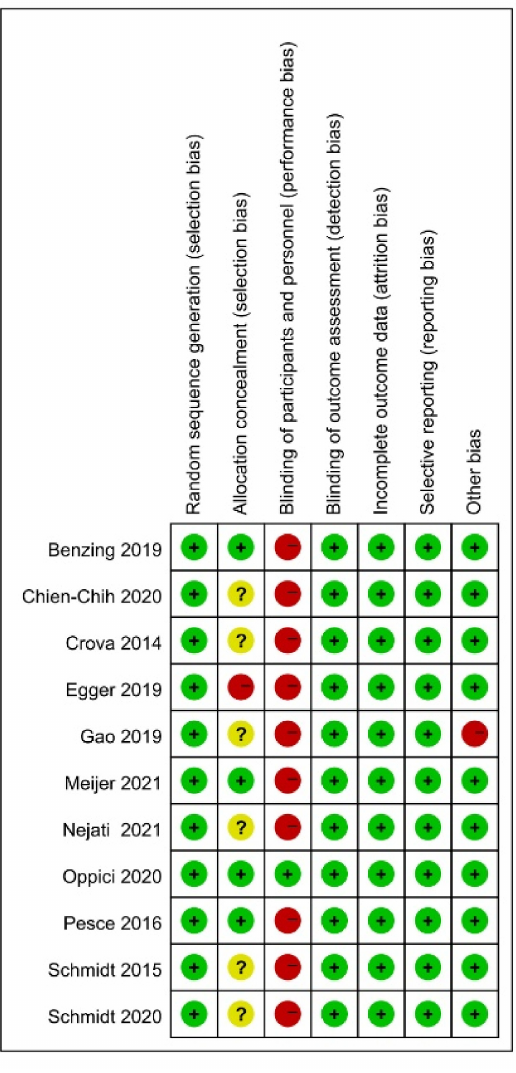
Figure 2. Quality evaluation results of included studies’ risk of bias (ROB). Ref. [23] ROB levels: low (green or “+”), unclear (yellow or “?”), and high (red or “ − ”).